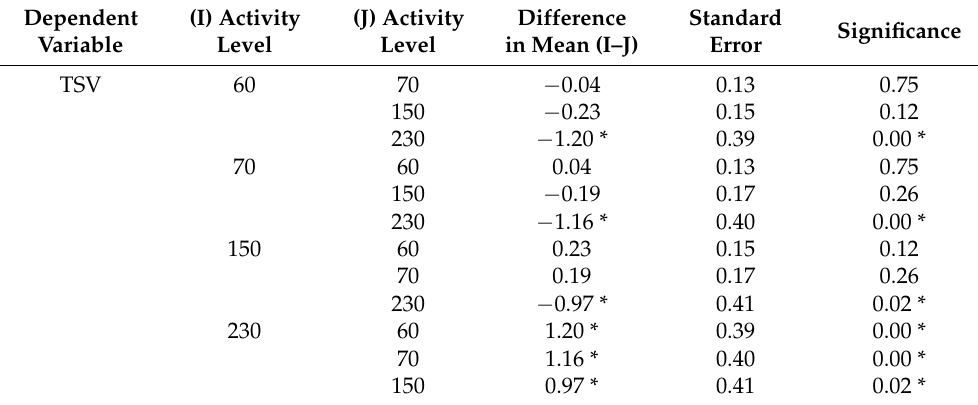
Table 10. Comparison of activity levels between groups.